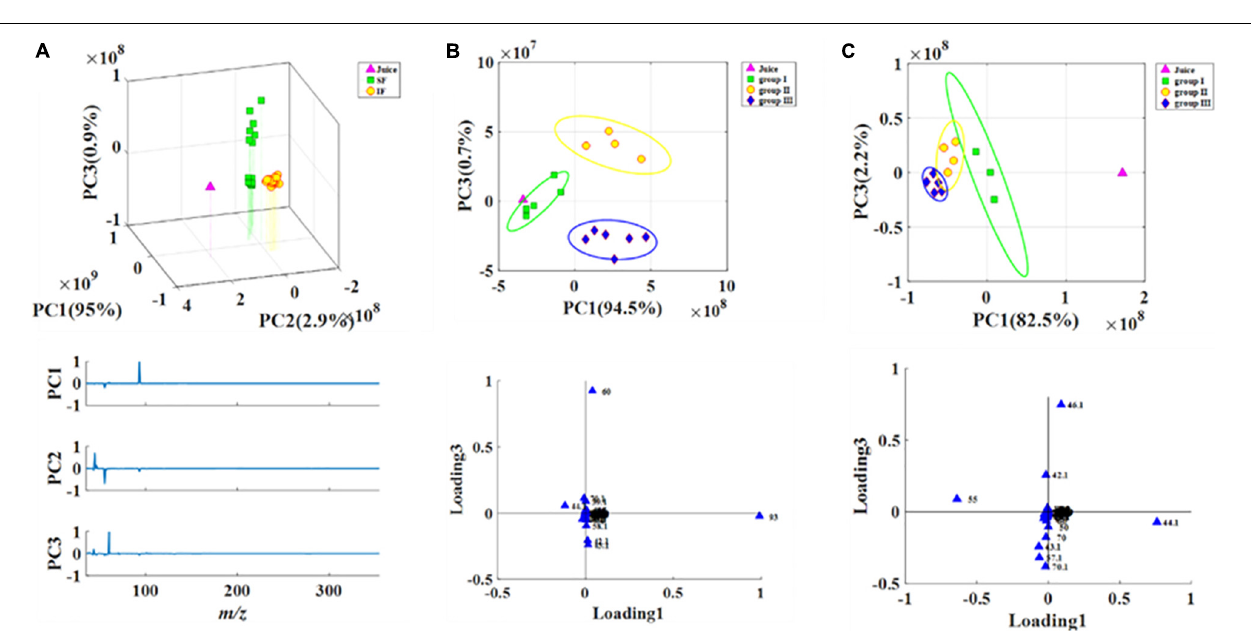
FIGURE 2 | Heatmap of change in metabolic profiling during the fermentation process ( A: SF; B: IF). Clustering analysis was performed using Pearson correlation and Euclidean distance based on the relative content of metabolites during the fermentation process. Data were processed by z-score transformation.